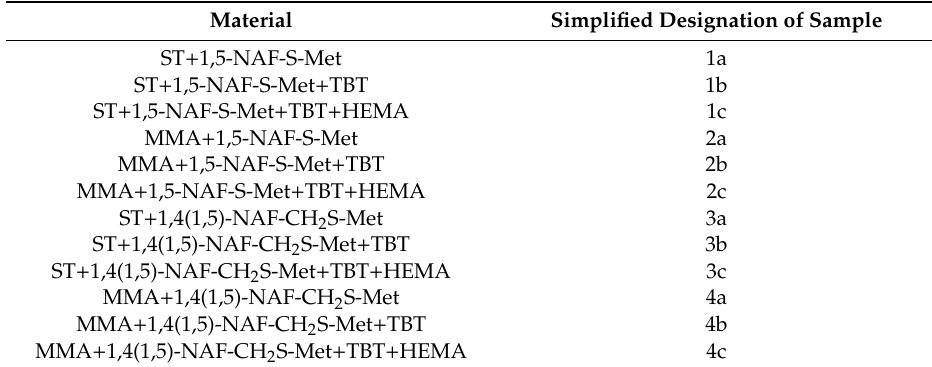
Table 2. Simplified designation of polymer sample